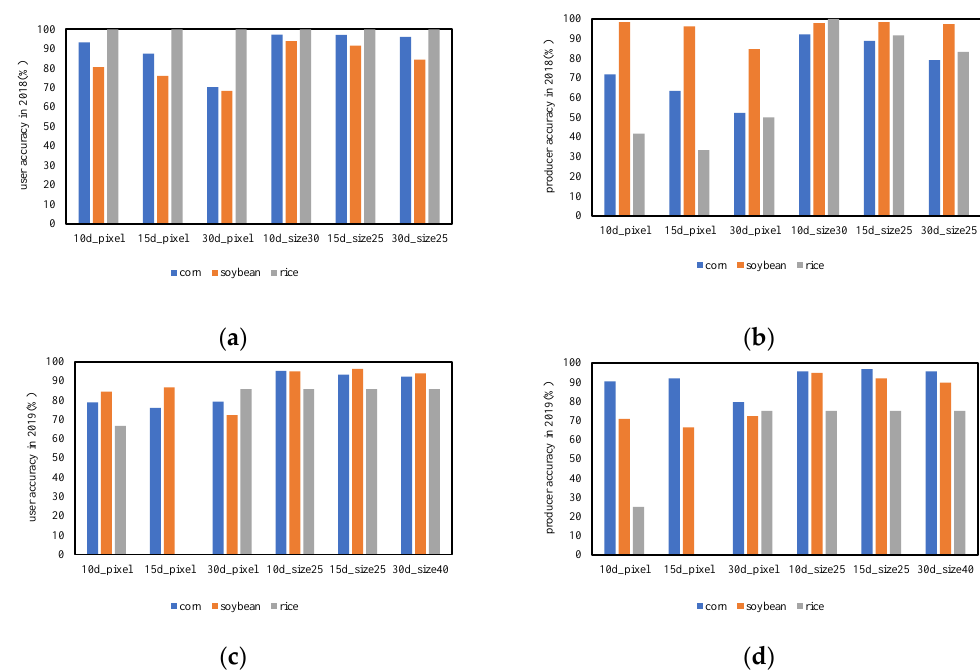
Figure 8. Producer accuracy and user accuracy of highest crop classification accuracy with different time intervals in Keshan farm at 2018 and 2019 (( a ) user accuracy in 2018; ( b ) producer accuracy in 2018; ( c ) user accuracy in 2019; ( d ) producer accuracy in 2019).